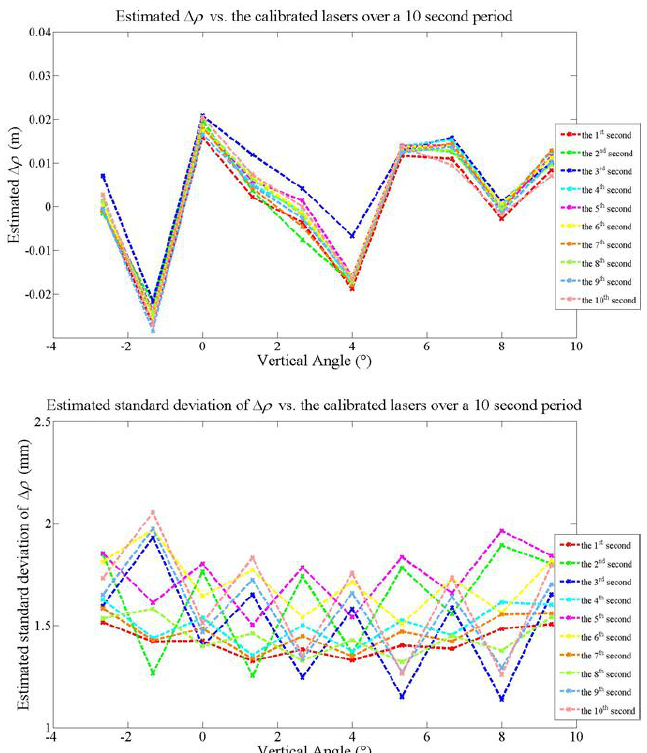
Figure 14. Estimated Δρ for Dataset 2 over a 10 second period (( a ) top). The standard deviations of estimated Δρ by the calibration for Dataset 2 over a 10 second period (( b ) bottom).